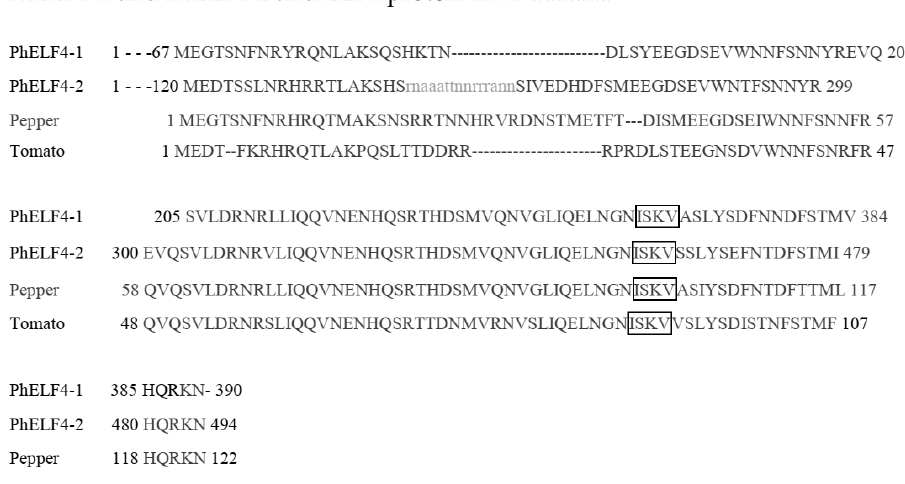
Figure 1. The amino acid sequence alignment of the predicted PhELF4-1 and PhELF4-2 proteins in petunia and ELF4 proteins of pepper and tomato. The box indicates the four conserved amino acid residues of the I(S / T / F)(K / R)V-type proteins from the DUF1313